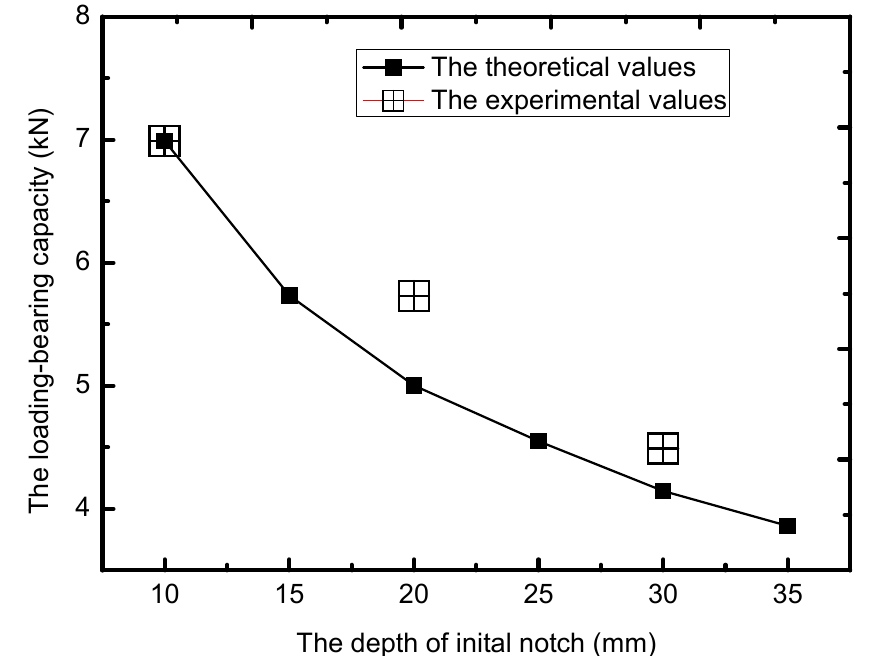
Figure 4. The comparison of the load-bearing capacity between theoretical and experimental values.